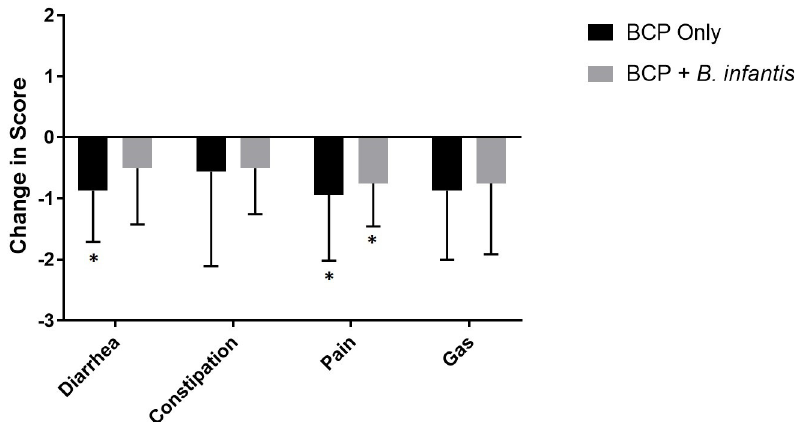
Fig 5. Change in gastrointestinal symptom frequency with treatment. Mean ± SD change in parental reported frequency of gastrointestinal symptom after treatment based on Likert-type scale where 0 = symptom never occurs, 1 = symptom rarely occurs, 2 = symptom sometimes occurs, 3 = symptom often occurs or 4 = symptom always occurs (n = 7 for diarrhea, n = 5 for constipation, n = 5 for pain and n = 6 for gas per group). Means that are significantly different from 0 (p < 0.05), indicating significant improvement, are denoted by an asterisk.